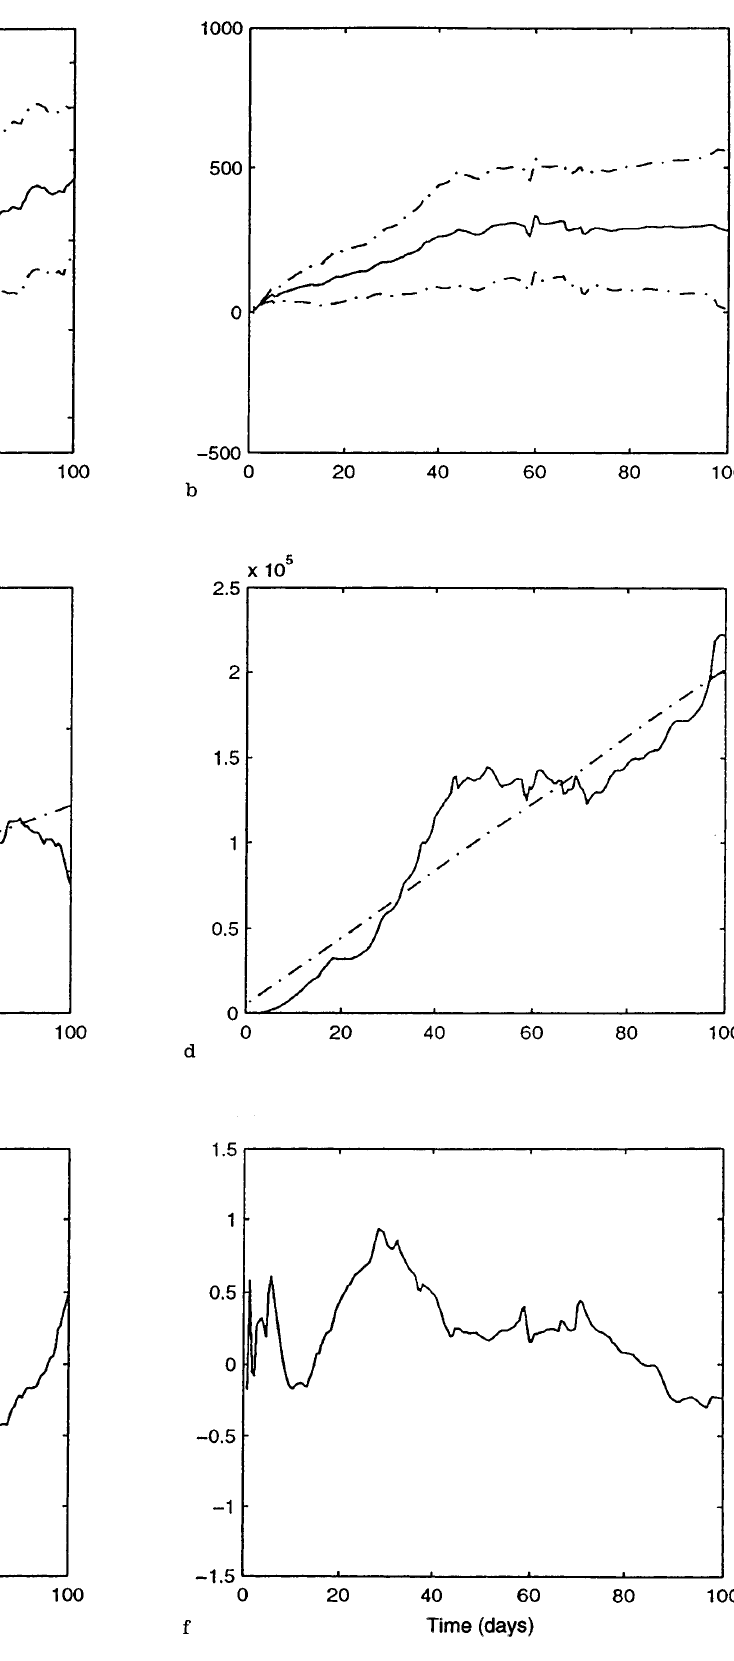
position X and Y respectively, c, d variance in position and e, f skewness of